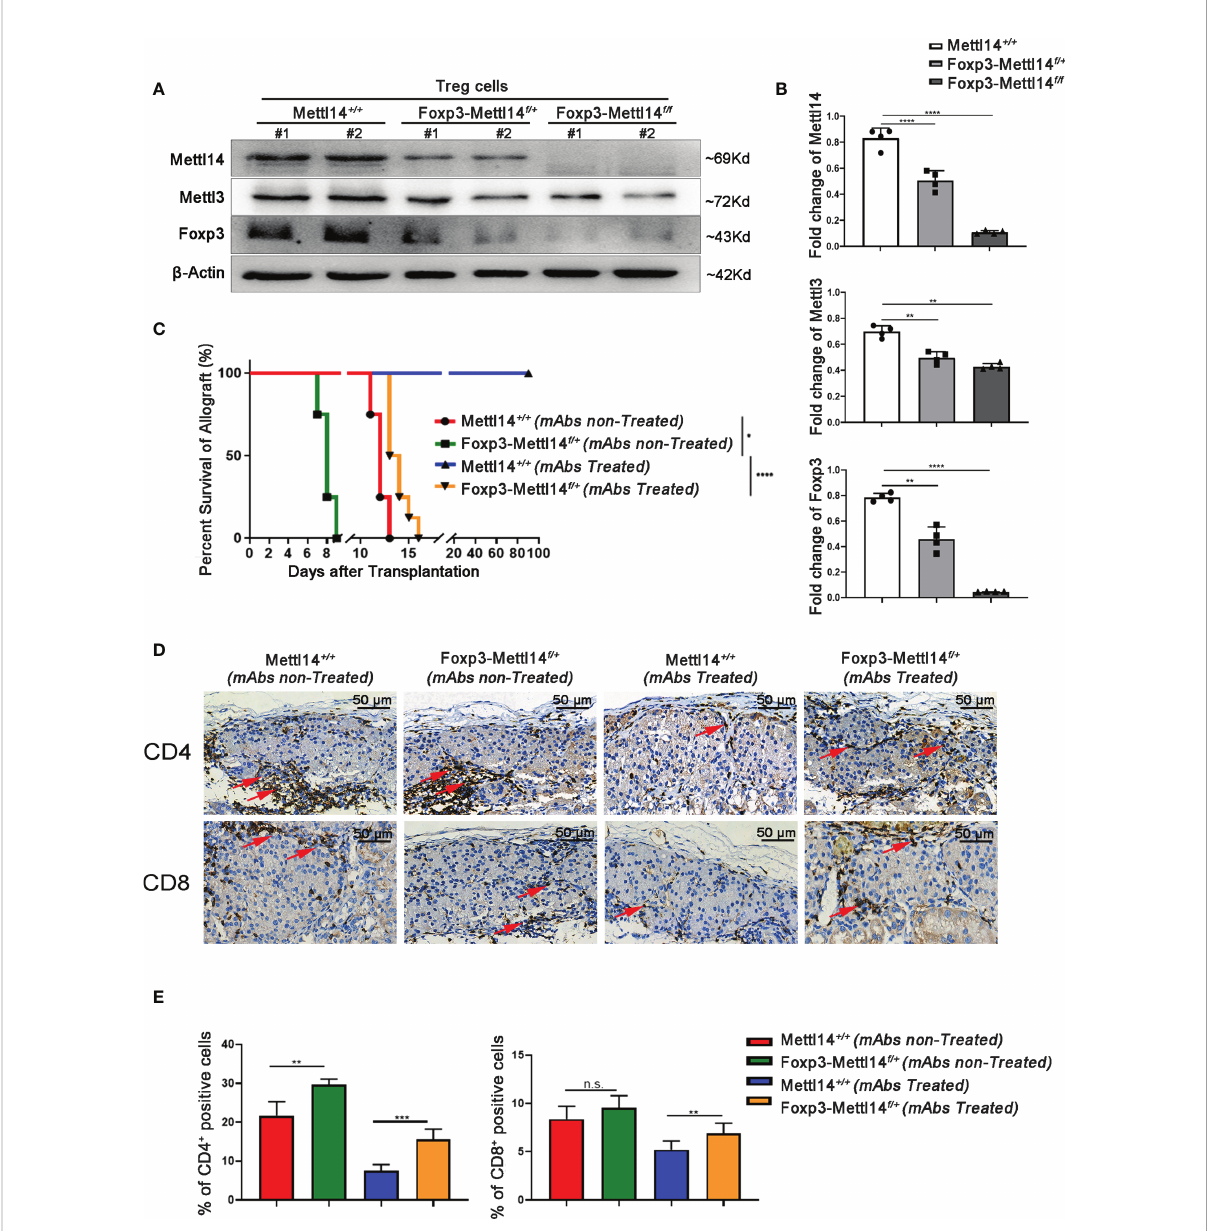
FIGURE 2 The METTL14-mediated m6A modi fi cation affected islet allograft tolerance. (A, B) Western blot analysis revealed that the expression of FOXP3, METTL14 and METTL3 in Treg cells isolation from Foxp3-Mettl14 f/+ and Foxp3-Mettl14 f/f cKO mice was signi fi cantly decreased compared to the levels in Treg cells from littermate controls. (C) Without mAbs treatment, allografts were rejected in littermate controls (n=7, 14 ± 1.2, red) and Foxp3-Mettl14 f/+ cKO mice (n=7, 7.9 ± 1.8, green). With mAbs treatment, long-term graft survival (blue) was observed in littermate controls, while islets allograft was rejected in Foxp3-Mettl14 f/+ cKO mice (n=7, 15 ± 3.2, yellow). (D, E) Immunohistochemistry and the quantitation of the results revealed the in fi ltration of CD4 + and CD8 + T cells around islet allografts on day 7 post-transplantation (red arrow), indicating severe in fl ammation in this region. The images (40×) were captured; scale bar 50 m m. The data are presents as the means ± SD and are representative of three separate experiments. The data in (B) depict the mean protein expression normalized to the gene b -Actin. The allograft survival